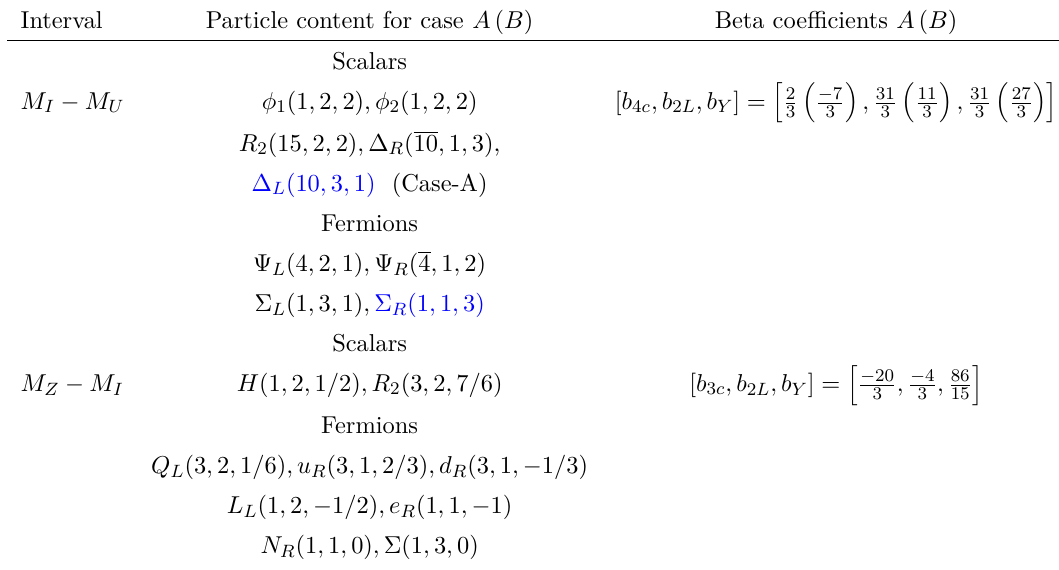
Table 1 . The particles (scalars and fermions) content and the Beta coefficients in the breaking intervals for case A and B. Case A is valid for intermediate PS symmetry with discrete D-parity invariance with the presence of extra fields marked in